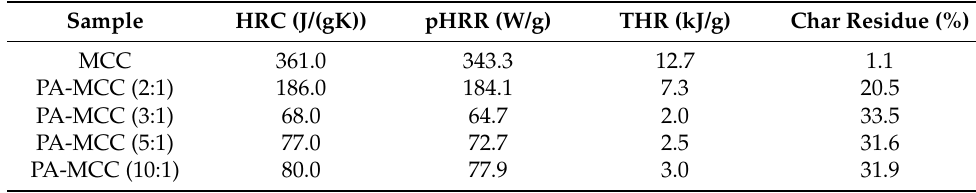
Table 2. PCFC data of PA-MCC obtained at various weight ratios of PA to MCC.